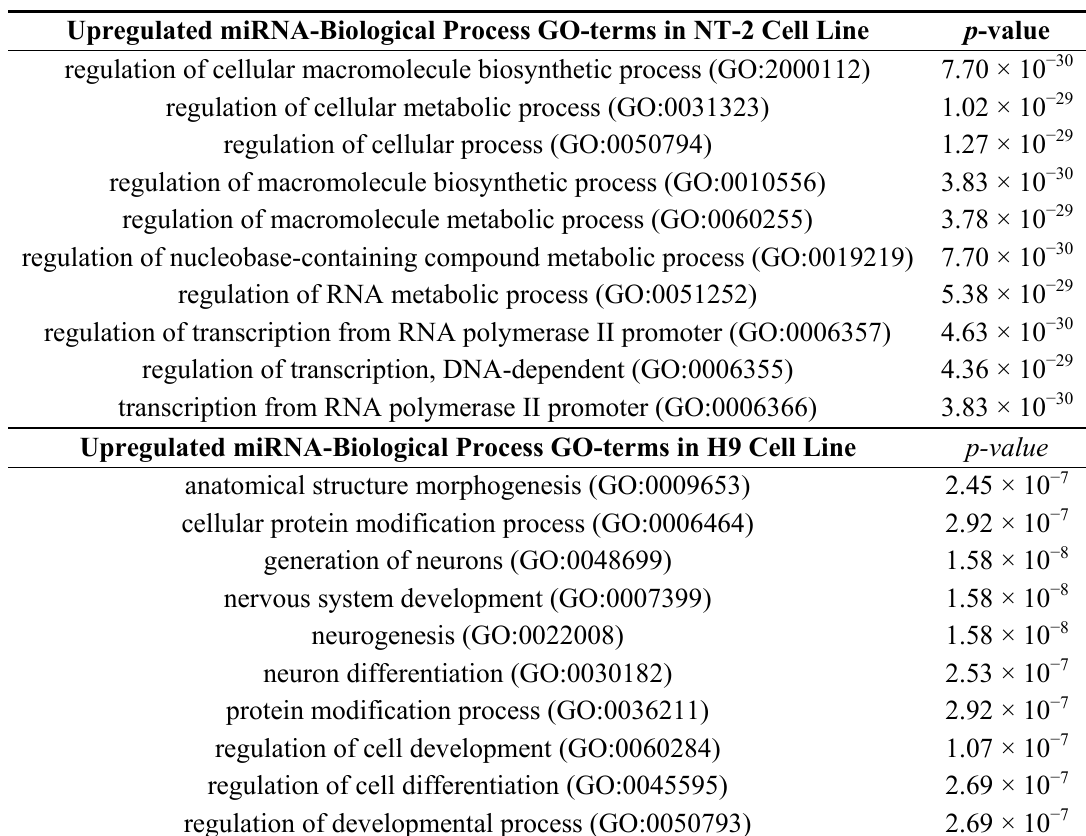
Table 2. Enriched miRNA-biological process gene ontology (GO)-terms in NT-2 and H9 cell lines. Analysis of Gene Ontology (GO) term enrichment for gene targets of deregulated miRNAs identified in the two cell cultures (H9 and NT-2) exposed to MeHgCl (compared to untreated cells).